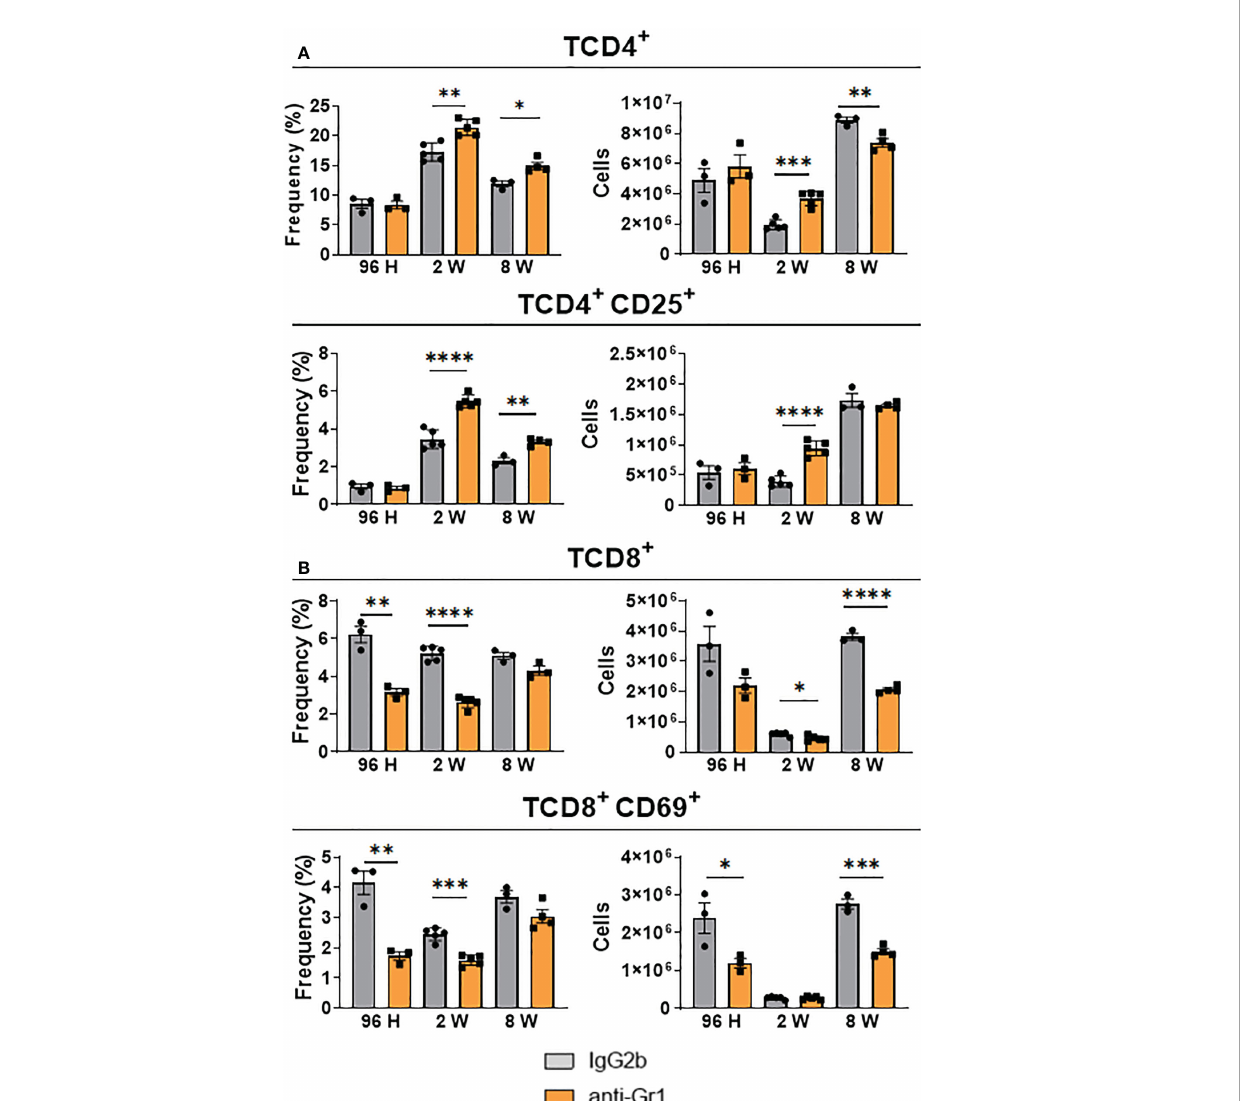
FIGURE 7 Effect of MDSC depletion in the presence of pulmonary T lymphocytes of P. brasiliensis -infected mice. The frequency and the absolute number of total and activated CD4 (A) and CD8 (B) T cells were evaluated in the lung-in fi ltrating leukocytes of anti-Gr1-treated and untreated infected mice. After 24 hours, 1 week, and 7 weeks of infection, a group of mice received intraperitoneal injections of anti-Gr1 antibody (clone RB6-8C5) or rat IgG2b isotype control antibody (200 µg/dose). After 96 hours, 2 weeks, and 8 weeks of infection lungs were removed, and leukocytes were obtained. The cells were gated by FSC/SSC analysis and lymphocytes were gated for CD4, CD25, CD8, and CD69 expression. Data represent three independent experiments with 3-4 mice each. For comparisons between two groups, the mean ± SEM was obtained and analyzed by the unpaired Student ’ s t -test. Differences were considered signi fi cant when: * p <0.05; ** p <0.01; *** p <0.001 and **** p